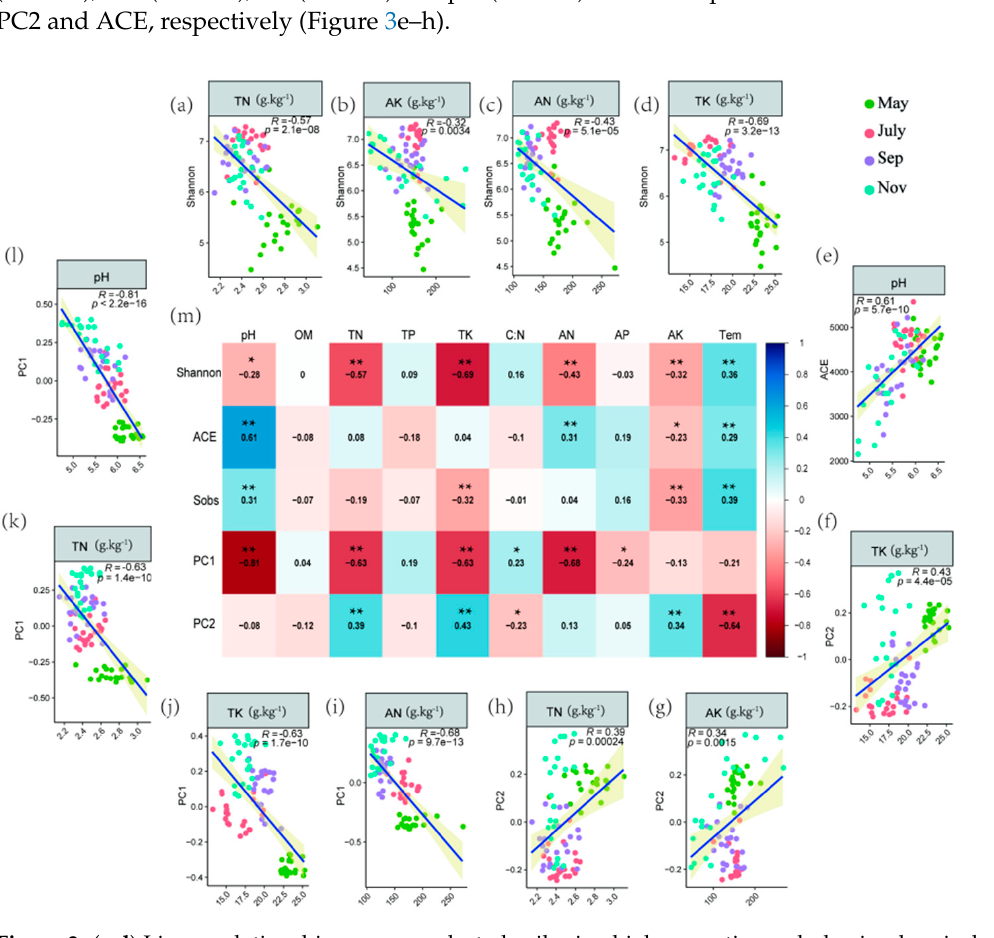
Table 1. Anosim analysis between sugarcane growth stages.